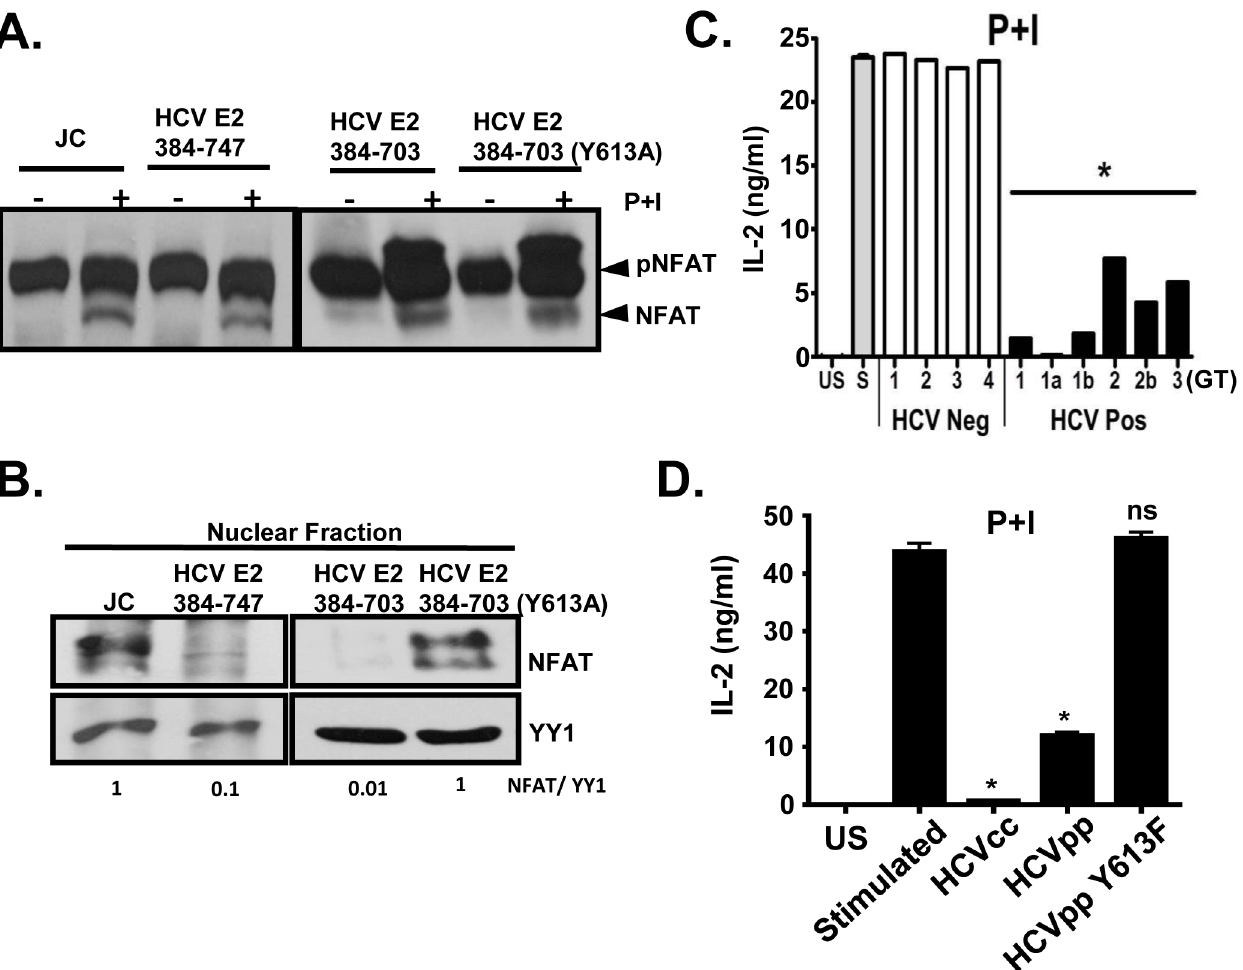
Fig 8. HCV E2 protein inhibits NFAT nuclear translocation. Dephosphorylation (A) and nuclear translocation (B) of the nuclear factor of activated T cells (NFAT) in Jurkat control cells or HCV E2 expressing cells as determined by immunoblot. The nuclear transcription factor Yin Yang 1 (YY1) served as the loading control for nuclear localization. P+I mediated IL-2 was release from primary healthy donor peripheral blood mononuclear cells (PBMCs) incubated with serum obtained from HCV positive (HCV+) humans infected with genotype (GT; 1, 1a, 1b, 2, 2b, and 3) HCV negative (HCV-) human subjects (C1-C4) (C) or cell-culture derived HCV particles (HCVcc) and retroviral particles pseudotyped with HCV envelope (E1-E2; HCVpps) or with HCV envelope containing the Y613F mutation (HCVpp Y613F) (D). US = unstimulated, and S = stimulated (no serum). Data represent the average of three technical replicates and the standard deviation is shown. Each experiment was repeated with three donors with consistent results * P <